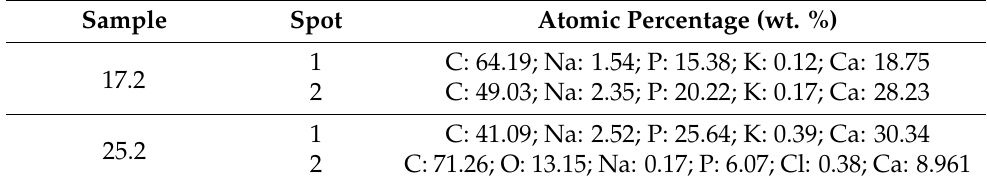
Table 3. Elemental composition of composites after incubation in PBS.